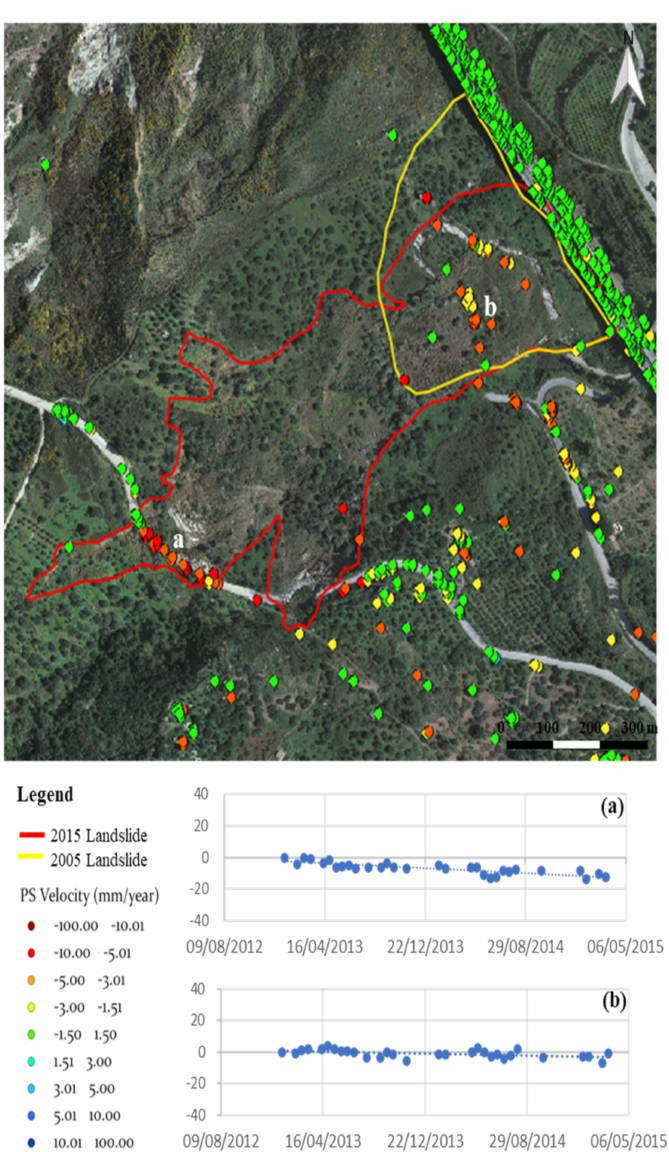
Figure 6. A-DInSAR pre-failure analysis for Scillato landslide (from [66], modified), including the average velocity map and the time series of displacement of two representative measurement points in sectors ( a ) and ( b ). (COSMO-SkyMed Product—©ASI—Agenzia Spaziale Italiana—(2017). All rights reserved). (Lat: 37.843329 ◦ ; Lon: 13.914881 ◦ ;